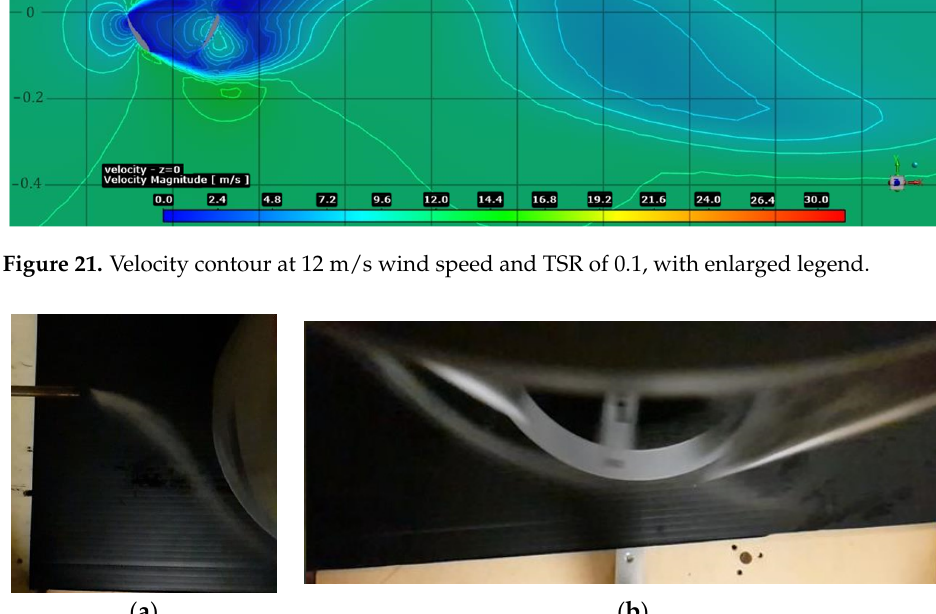
Figure 22. Smoke flow: ( a ) From the inlet; ( b ) Around the returning side.